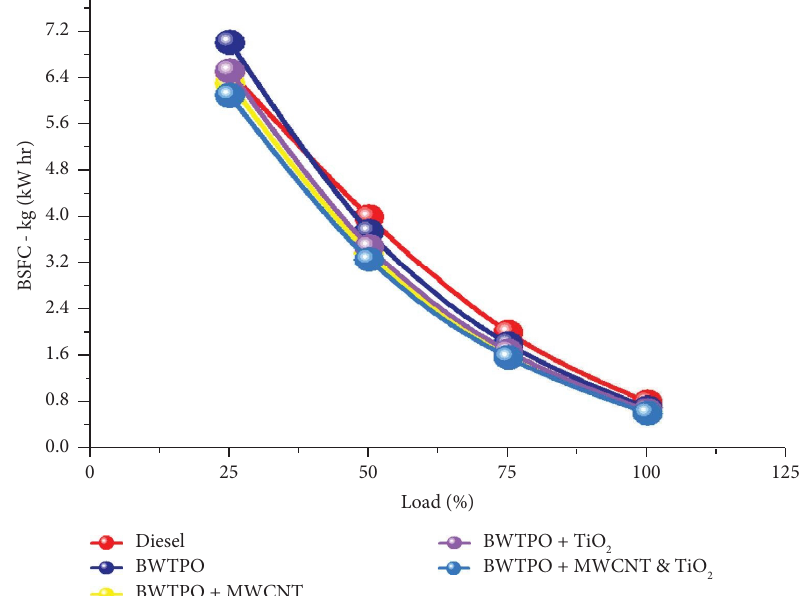
Figure 6: Relationship between specifc fuel consumption (kg/kW · hr) and load variations